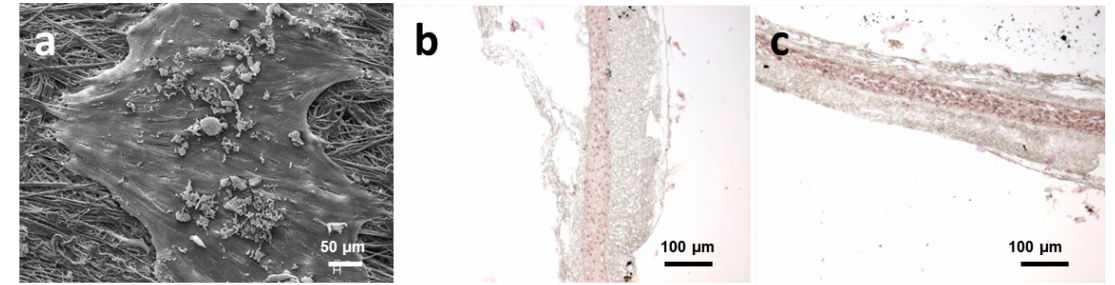
Figure 13. SEM ( a ) and IHC analysis ( b = TE-7, c = CD31) of seeded PU after flow exposure (100 dyn/cm 2 ) in the bioreactor system show single cells on the surface of the scaffolds.